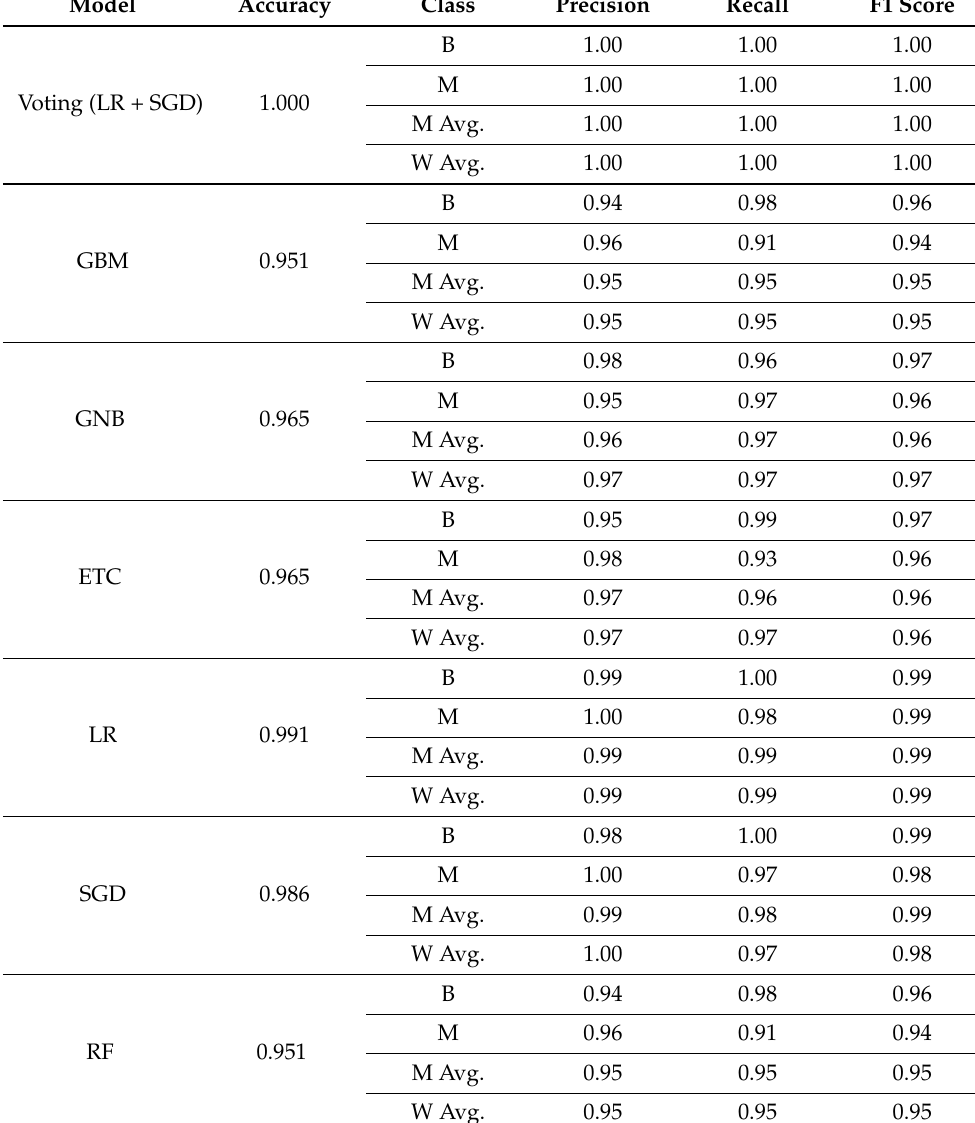
Table 5. Models’ performance using convoluted features from CNN. Model Accuracy Class Precision Recall F1